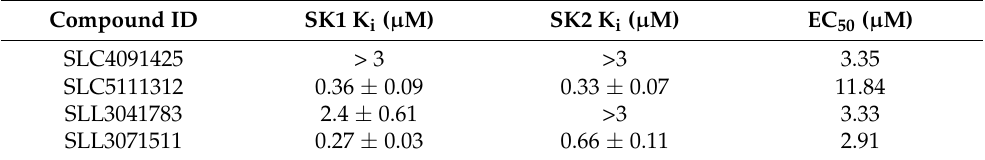
Table 1. The activity of the positive CHIKV inhibitor candidates against SK1 and SK2 and CHIKV. Compound